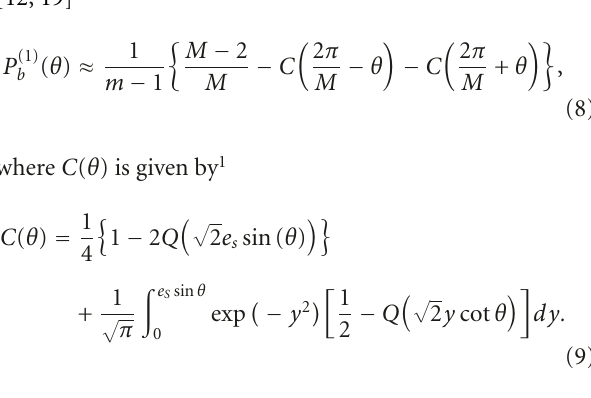
by splitting each point in the QPSK constellation into two points, each of which is rotated away from the original QPSK point by an angle θ , as illustrated in Figure 2(b). The result is a nonuniform 8-PSK signal constellation with signals at an- gles θ , − θ , π/ 2+ θ , π/ 2 − θ , π + θ , π − θ , − π/ 2+ θ , − π/ 2 − θ . The base-layer data are represented by the pairs of binary sym- bols that appear as labels on the points in the constellation of Figure 2(a). The base-layer data also appear as the first two bits of the labels of the points in the 8-PSK constellation of Figure 2(b). The third bit of each label in Figure 2(b) is de- rived from the enhancement-layer data. The relative proba- bilities of error for the two message streams are controlled by varying the modulation parameter θ , which is referred to as the o ff set angle in [19].